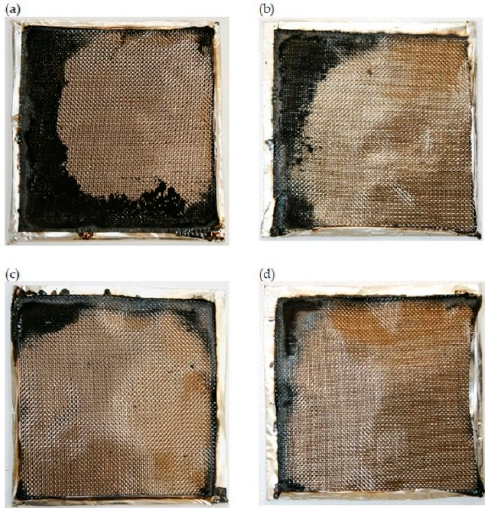
Figure 8. Photographs of samples after cone calorimetry tests: ( a ) 0PVC, ( b ) 2.5PVC, ( c ) 5PVC, ( d ) 10PVC.